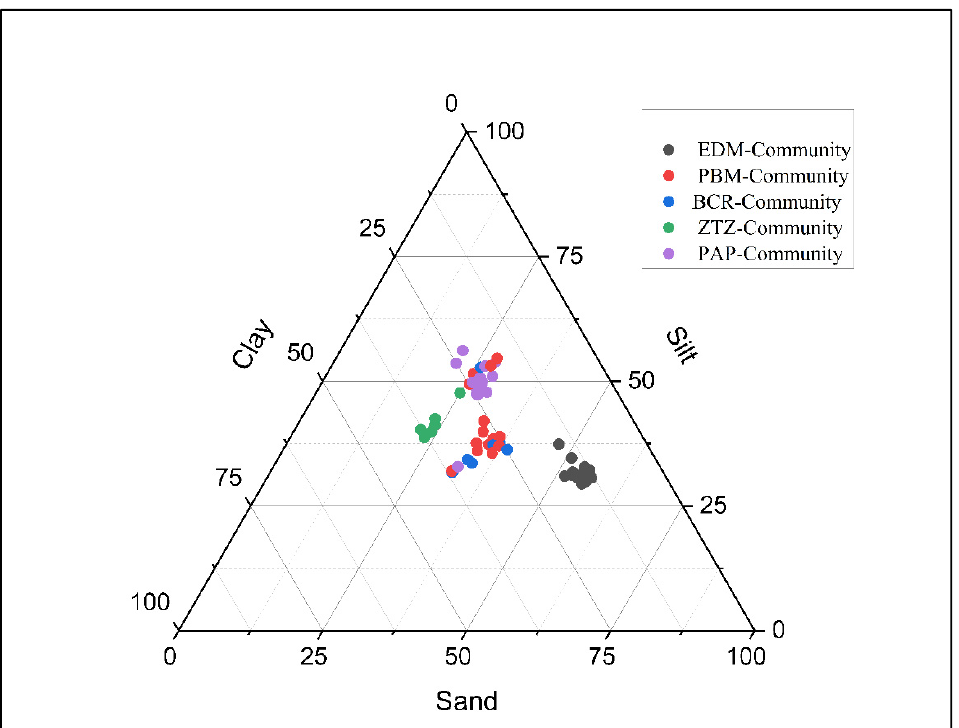
Figure 7. CCA analysis of woody vegetation in semi-arid lowland district Kasur Punjab, Pakistan.